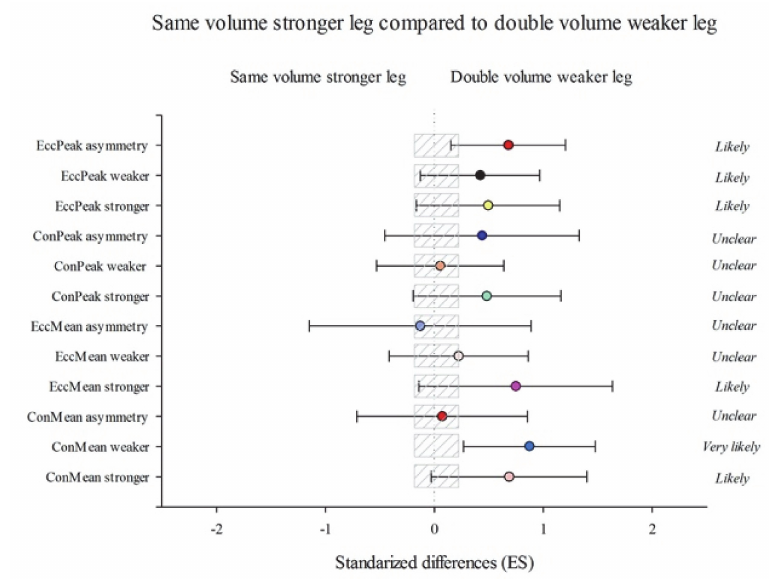
Figure 3. Efficiency of the unilateral eccentric overload training performing the same volume with both legs starting with the stronger leg (SVS) compared with the unilateral eccentric overload training performing the double volume with the weaker leg, starting with the weaker leg (DVW). Training program to improve a lateral squat in mean concentric power (ConMean) with the stronger and the weaker leg and the corresponding asymmetry; mean eccentric power (EccMean) with the stronger and the weaker leg and the corresponding asymmetry; maximum peak concentric power (ConPeak) the stronger and the weaker leg and the corresponding asymmetry; maximum peak eccentric power (EccPeak) with the stronger and the weaker leg and the corresponding asymmetry. (Bars indicate uncertainty in the true mean changes with 90% confidence limits.) Trivial areas were the smallest worthwhile change (see Section 2).